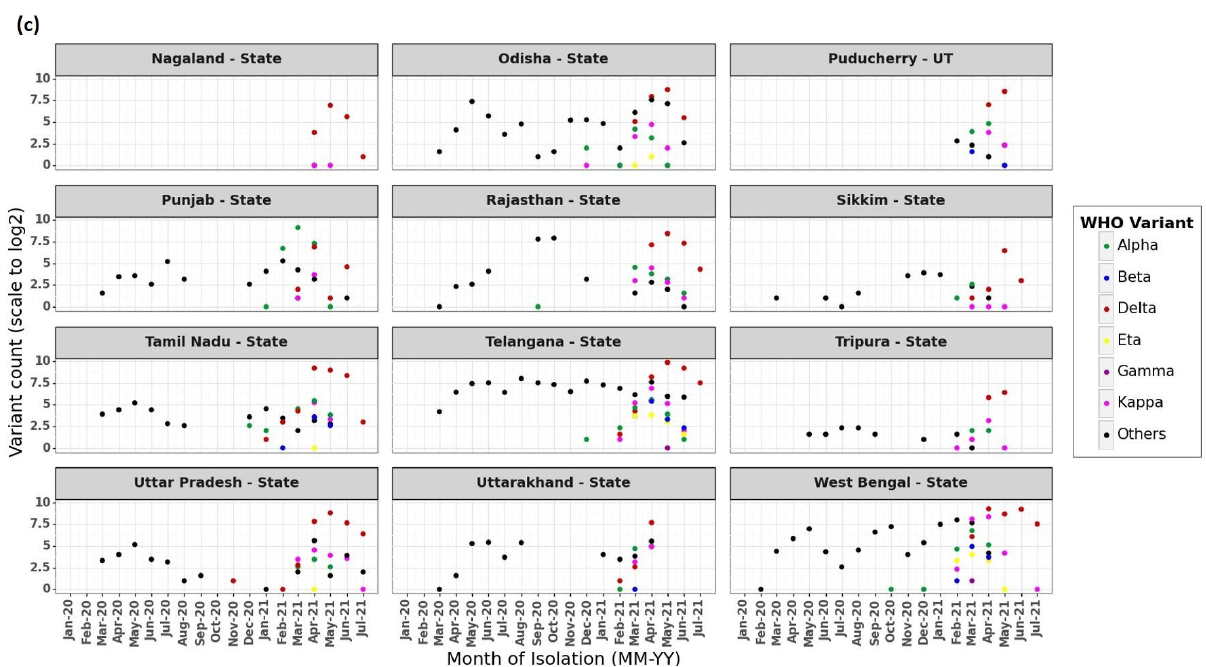
Figure 2. ( a – c ): Frequency distribution of VoC and VoI circulating in various States and UTs of India during 17 months (January 2020–July 2021) of the SARS-CoV-2 pandemic. Note: X -axis denotes month of isolation and Y -axis denotes variant count scaled to log 2.